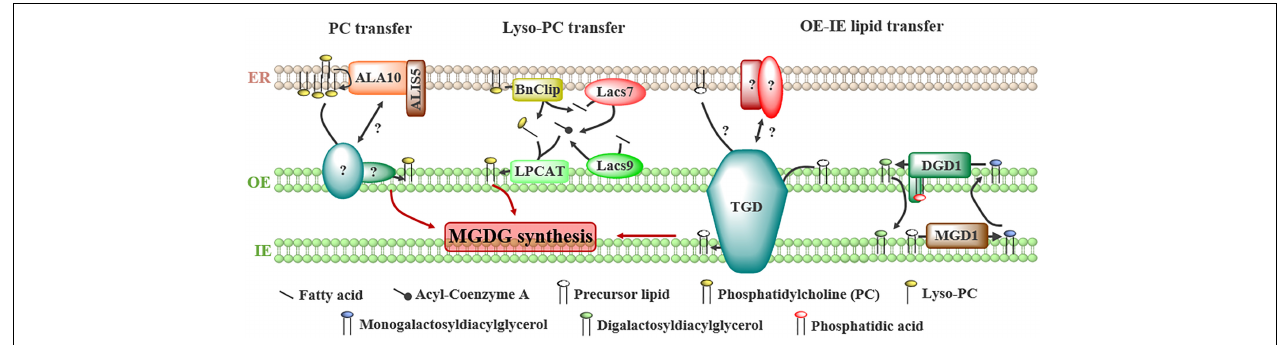
FIGURE 2 | Proteins involved in the transport of lipids from the ER to plastids and between the outer (OE) and the inner (IE) envelope of plastids to fulfill galactoglycerolipid synthesis. Several precursors have been proposed to be transported from ER: (1) phosphatidylcholine (PC), whose transfer is stimulated by the flippase ALA10 located at ER-plastids junctions by interacting with ALIS5, (2) lyso-PC, generated from PC by a lipase, BnClip1, and reacylated in the OE by a lyso-PC acyltransferase (LPCAT) from acyl-Coenzyme A synthesized at ER-plastids contact sites by the long-chain acyl-CoA synthases LACS7 and LACS9, (3) unknown precursors or galactolipids transported from the OE to the inner envelope (IE) by the trigalactosyldiacylglycerol (TGD) complex or the digalactosyldiacylglycerol (DGDG) synthase DGD1.